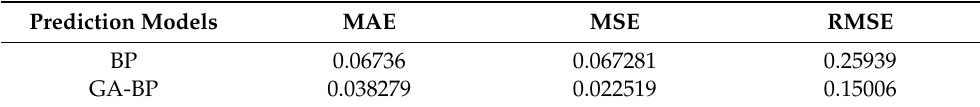
Table 4. Comparison of model prediction